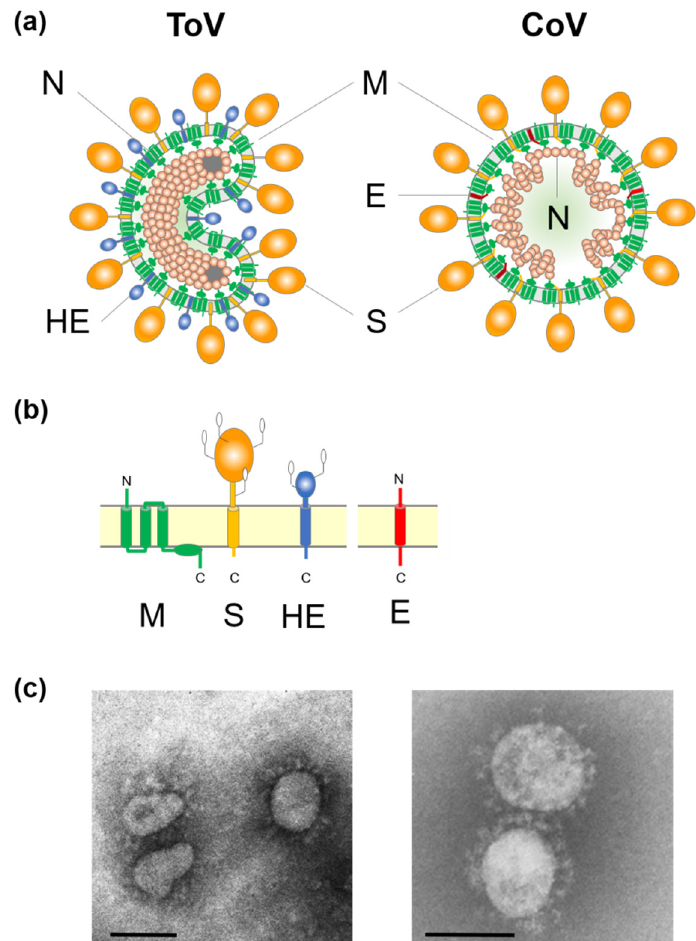
Figure 1. ( a ) Schematic diagrams of torovirus (ToV) and coronavirus (CoV) virions: spike (S), envelope (E), membrane (M), haemagglutinin-esterase (HE), and nucleocapsid (N) proteins. ( b ) Topology of the four structural envelope proteins. All proteins are depicted as monomers, but the S and HE proteins form homotrimers and homodimers, respectively. Oli- gosaccharides on the S and HE proteins are shown. Although a number are omitted, the S and HE proteins contain 19 to 28 and 7 to 12 N-glycosylation sites, respectively. ( c ) Electron micrograph of BToV (left) and SARS-CoV (right). Bar: 100 nm.